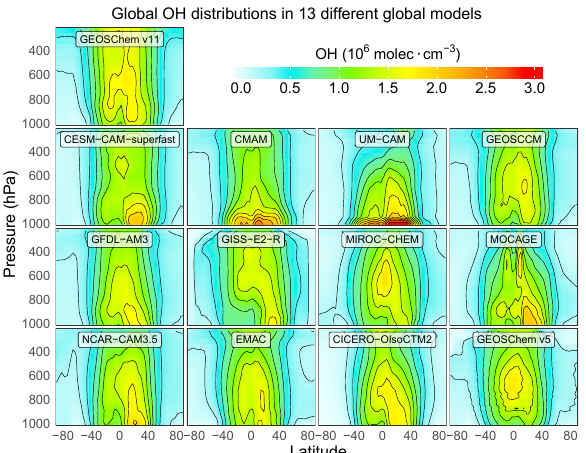
Figure 9. Variability of OH distributions across global models. The figure shows annual zonal mean OH concentrations for 13 different models used in the OSSE. GEOS-Chem v11 is used in the forward model for the inversion with τ OH used for the baseline true atmosphere with τ OH other 11 distributions are from the ACCMIP model ensemble (Naik et al., 2013), with global scaling factors to impose τ OH in all cases, and are used in alternative representations of the true atmosphere.